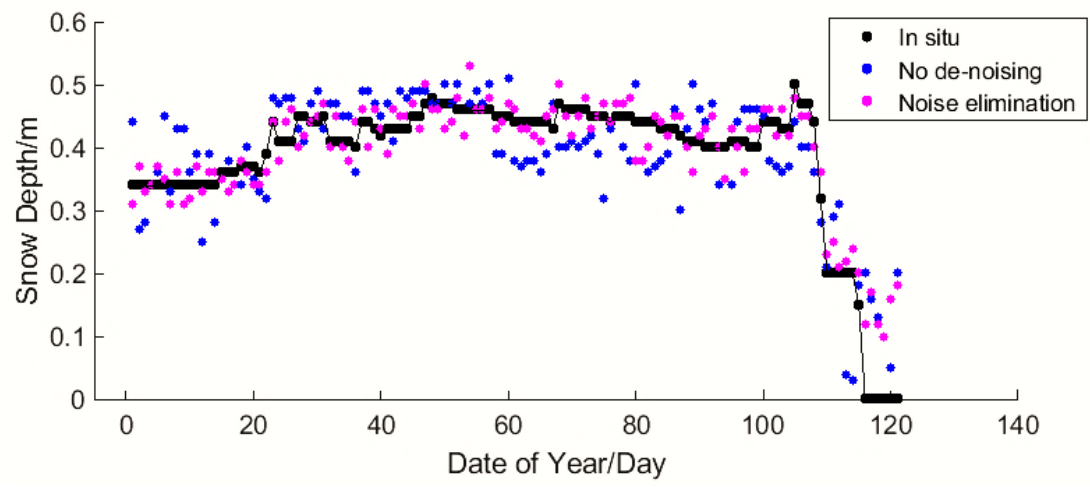
Figure 4 comparison diagram of 5° ~ 25° polynomial, wavelet denoising and actual